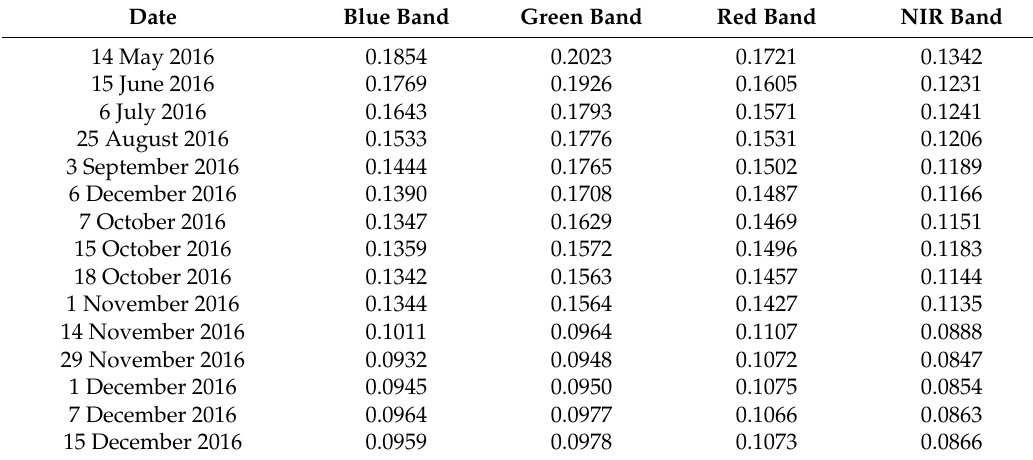
Table 9. Calibration coefficients for